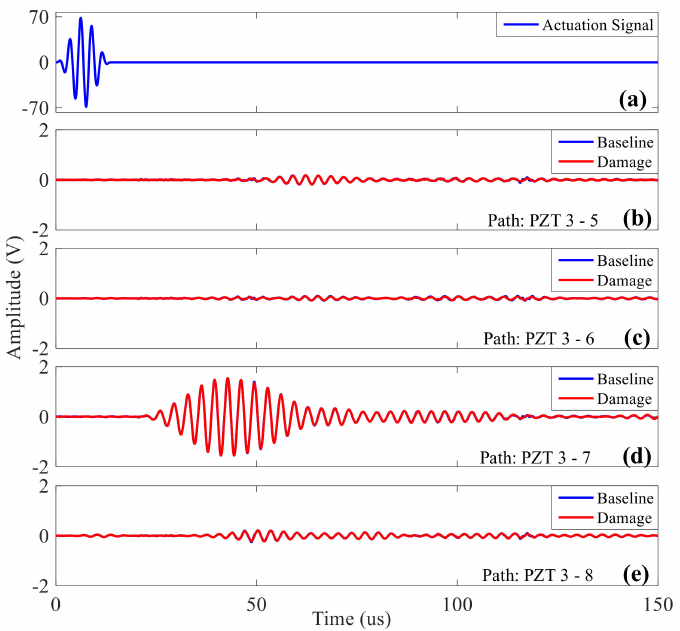
Figure 15. Comparison diagram of reference signal and damage signal in di ff erent paths: ( a ) 300 kHz actuation signal; ( b ) PZT three-actuation-five-acquisition; ( c ) PZT three-actuation-six-acquisition; ( d ) PZT three-actuation-seven-acquisition; ( e ) PZT three-actuation-eight-acquisition.